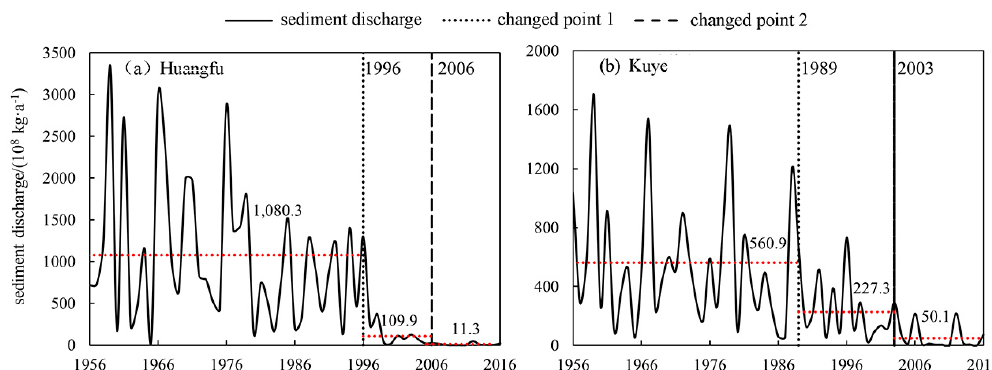
Figure 3. Variations of annual sediment discharge in the Huangfu basin ( a ) and the Kuye basin ( b ).